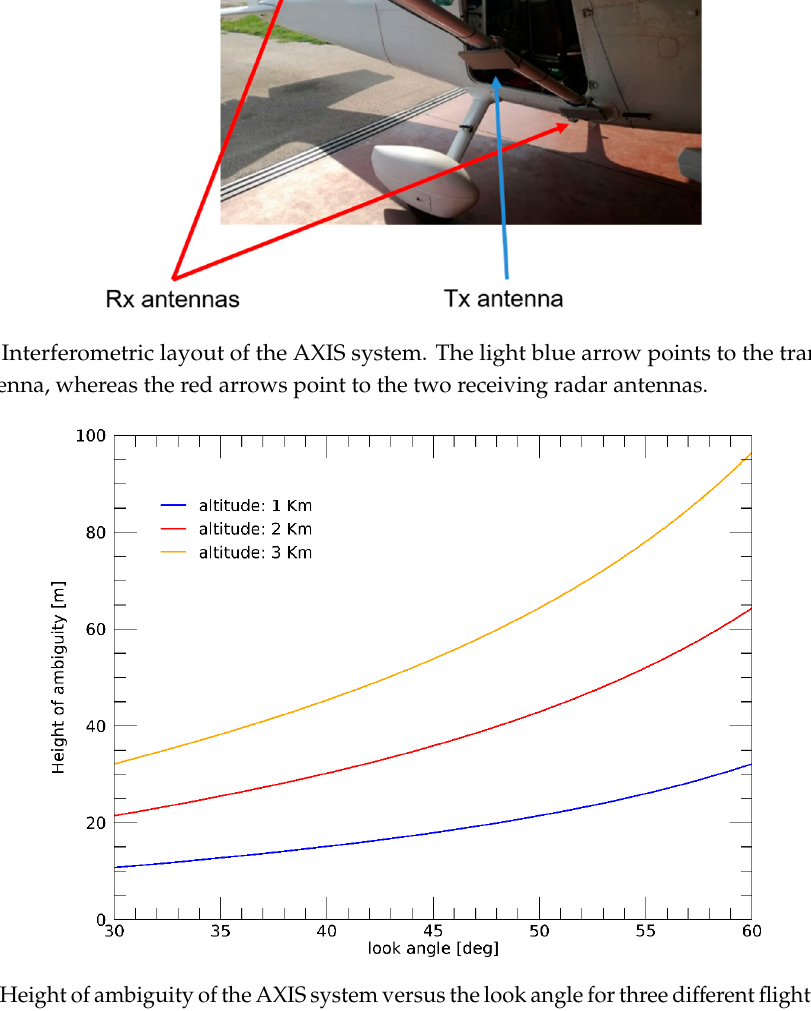
Figure 3. Height of ambiguity of the AXIS system versus the look angle for three different flight altitudes.